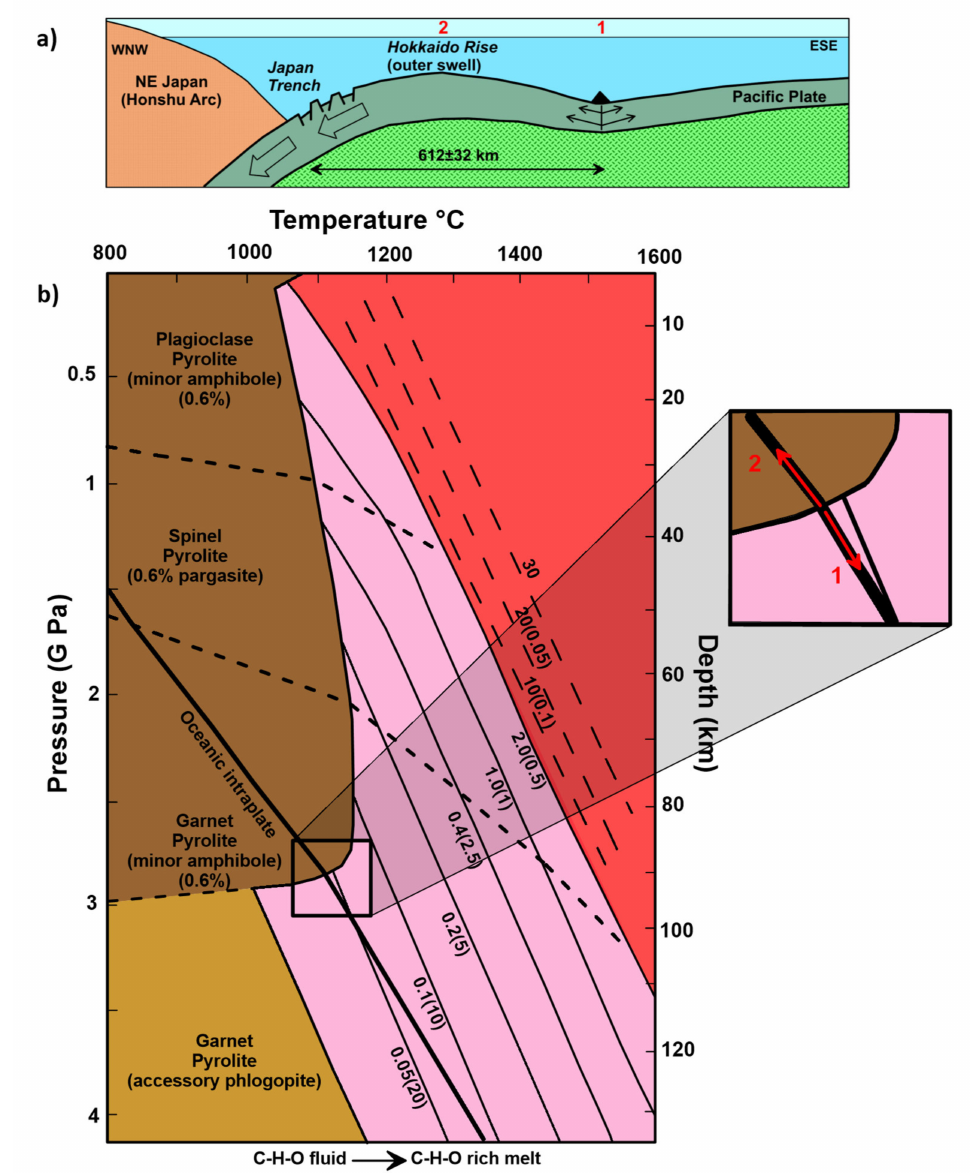
Figure 16. ( a ) Schematic outline of the ‘plate flexure model’ based on Figure 7 from [129]; ( b ) Ex- perimentally determined pressure (GPa) and temperature ( ◦ C) phase relationships for pyrolite and pyrolite + (C + H + O) containing 200 ppm H 2 O and 100 ppm CO 2 (water-undersaturated con- ditions; [130,131]). The ‘Oceanic intraplate’ geotherm (thick black line) represents a geothermal gradient for old thick ocean crust, appropriate for petit-spot magmatism. If the oceanic lithosphere has ƒO 2 ≥ IW + 2 log units, then the solidus along this geotherm is defined by paragasite dehydra- tion melting which occurs at ~90 km (~2.7 GPa) at ~1070 ◦ C [132]. This intersection provides a petrological argument for a rheological change from lithosphere to asthenosphere with the presence of an incipient melt fraction (pink field %F < 2; %F > 2 is the ‘major’ melting regime in red, %F is weight fraction of melt expressed as a percentage). Dark and light brown fields are sub-solidus. Contours are marked with %F and dissolved water content (in brackets). Dashed contours within the major melting regime are for volatile free melting (volatile contents are so low that they have no significant influence on melting relationships). Inset shows the change in phase relationships as the oceanic lithosphere undergoes lithospheric